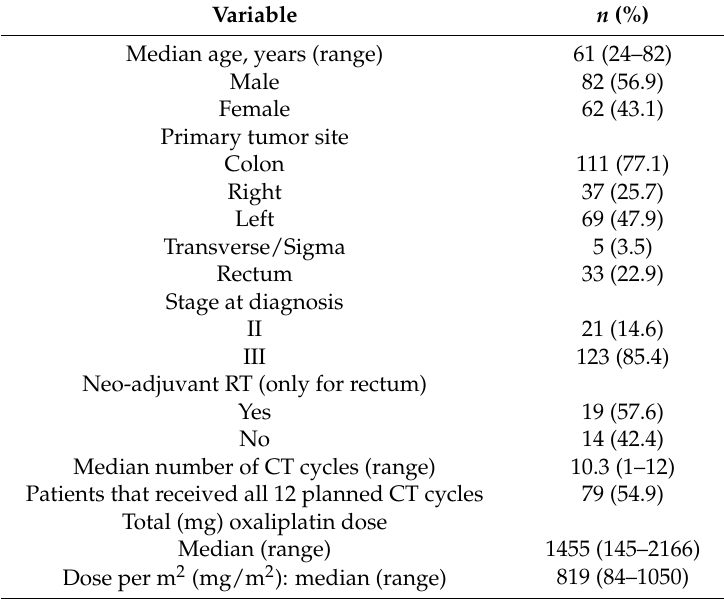
Table 1. Eligible patient characteristics ( n =